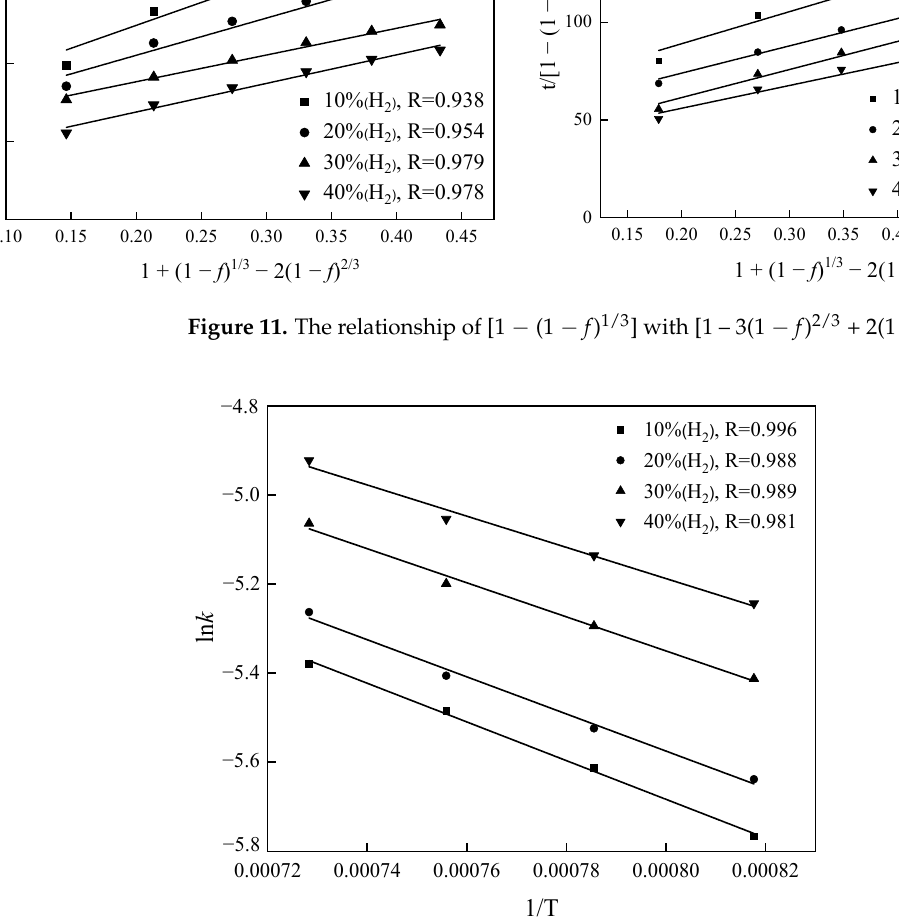
Figure 12. The relationship of lnk -1/ T . The values of ∆ E and A can be obtained from the slope and intercept of the line, respectively. The results are shown in Table 5. Table 5. Relationship between lnk and 1/ T in different reducing atmospheres.